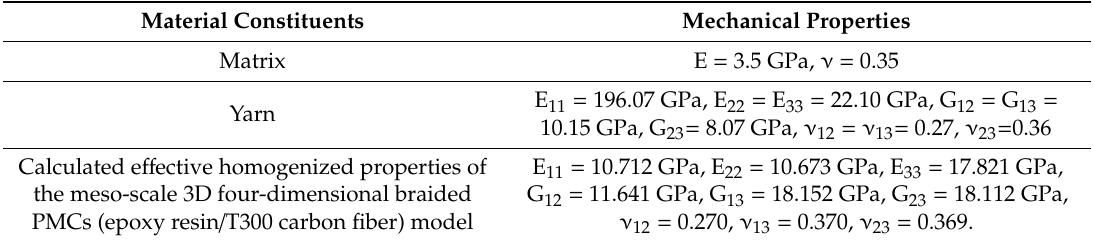
Table 2. Calculated mechanical properties of the braided polymer matrix composites (PMCs) with its constituents (Matrix and Yarn).